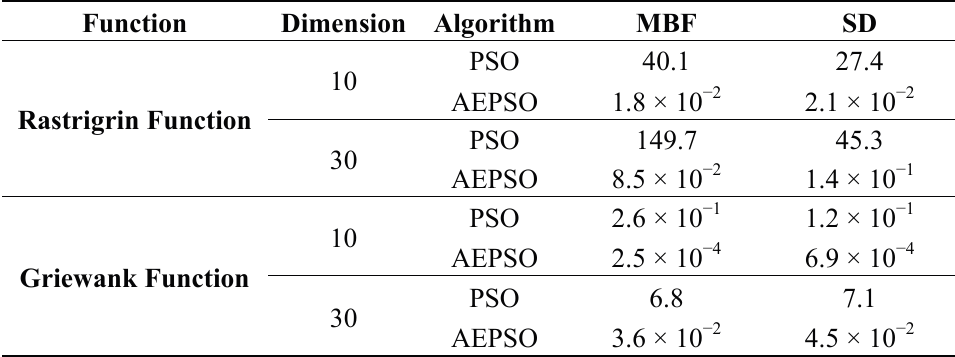
Table 3. Simulation results.